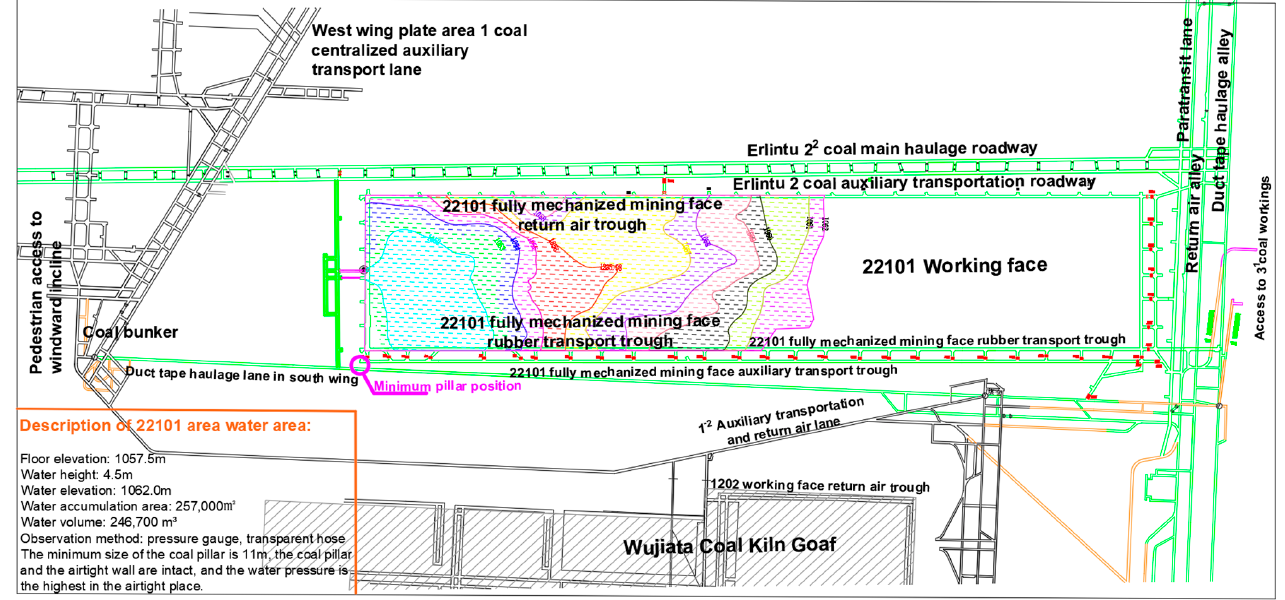
Figure 1. Schematic diagram of closed water storage in the goaf of 22101 working face of Shangwan Coal Mine.